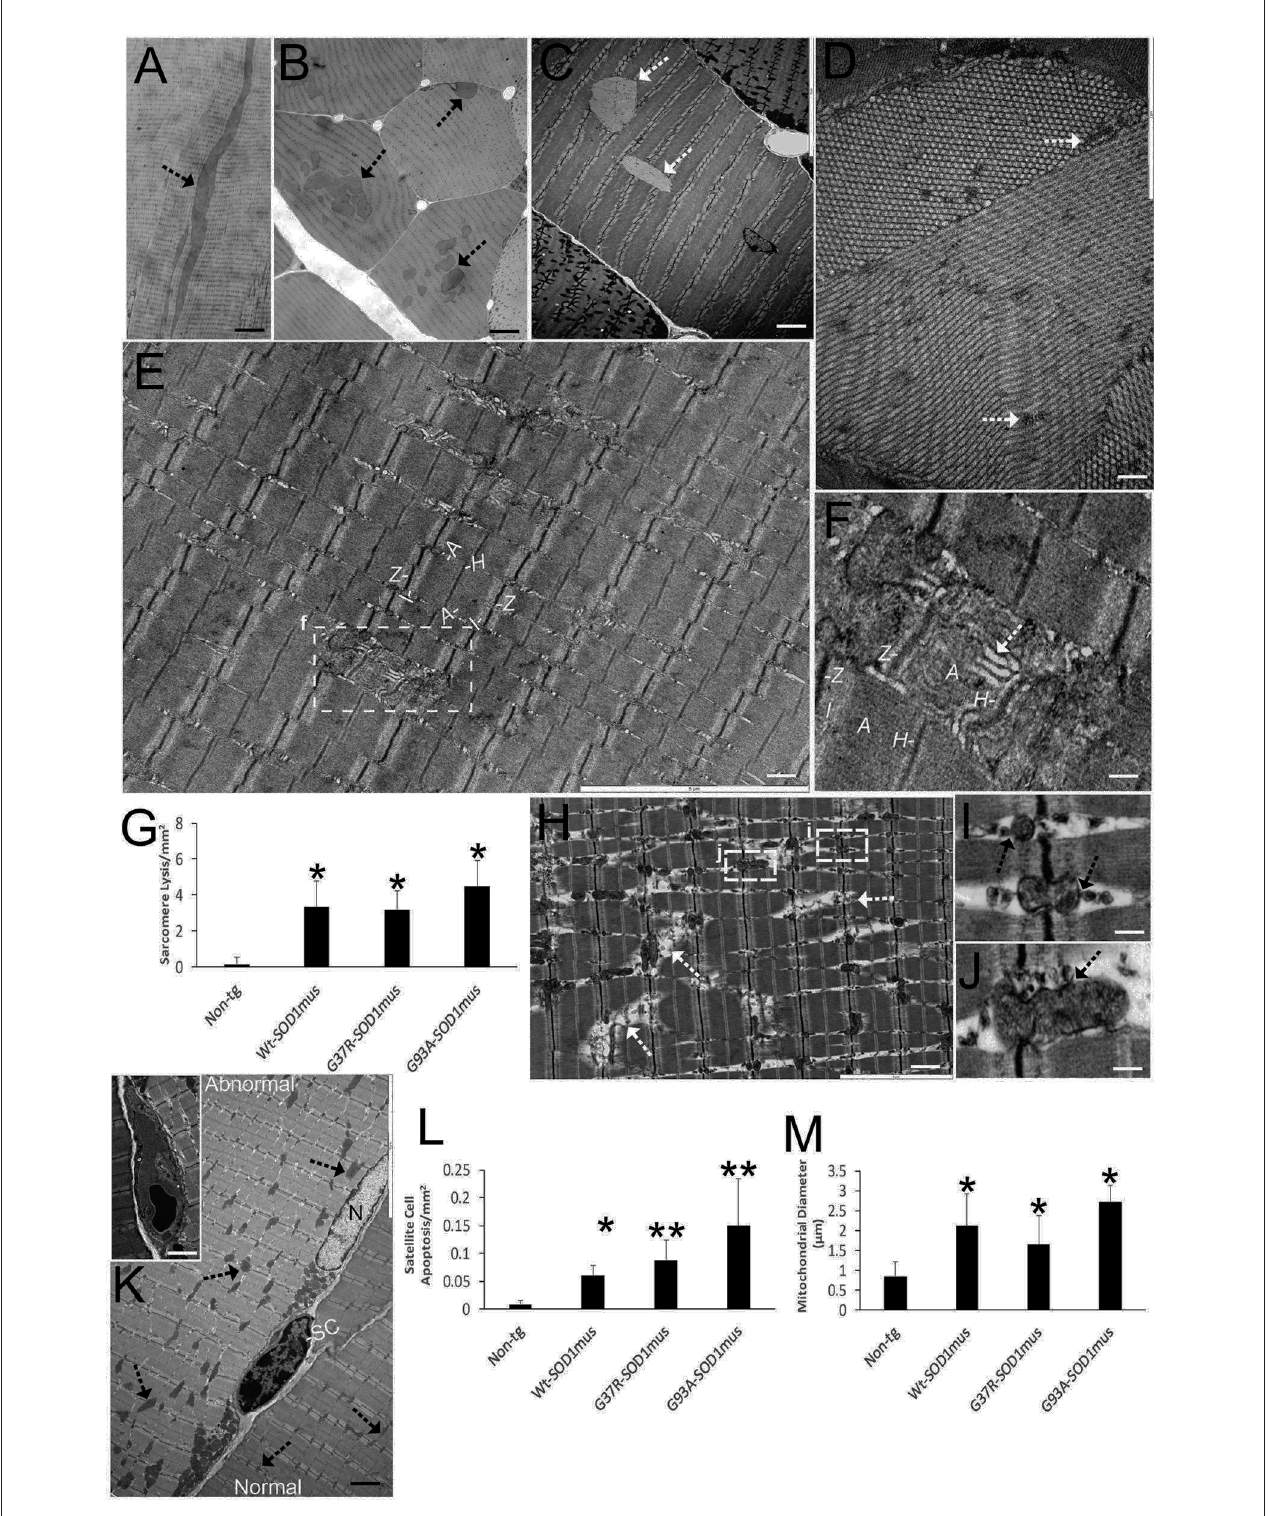
FIGURE 3 | EM shows that skeletal muscle of hSOD1 mus mice develops myofiber inclusions, sarcomere degeneration, mitochondriopathy, and satellite cell apoptosis. (A,B) Plastic sections (0.5 µ m thick) showing intramyofibrillar inclusions (arrows) in longitudinal (A) and cross-section (B) profiles. Scale bars = 225 µ m (A)